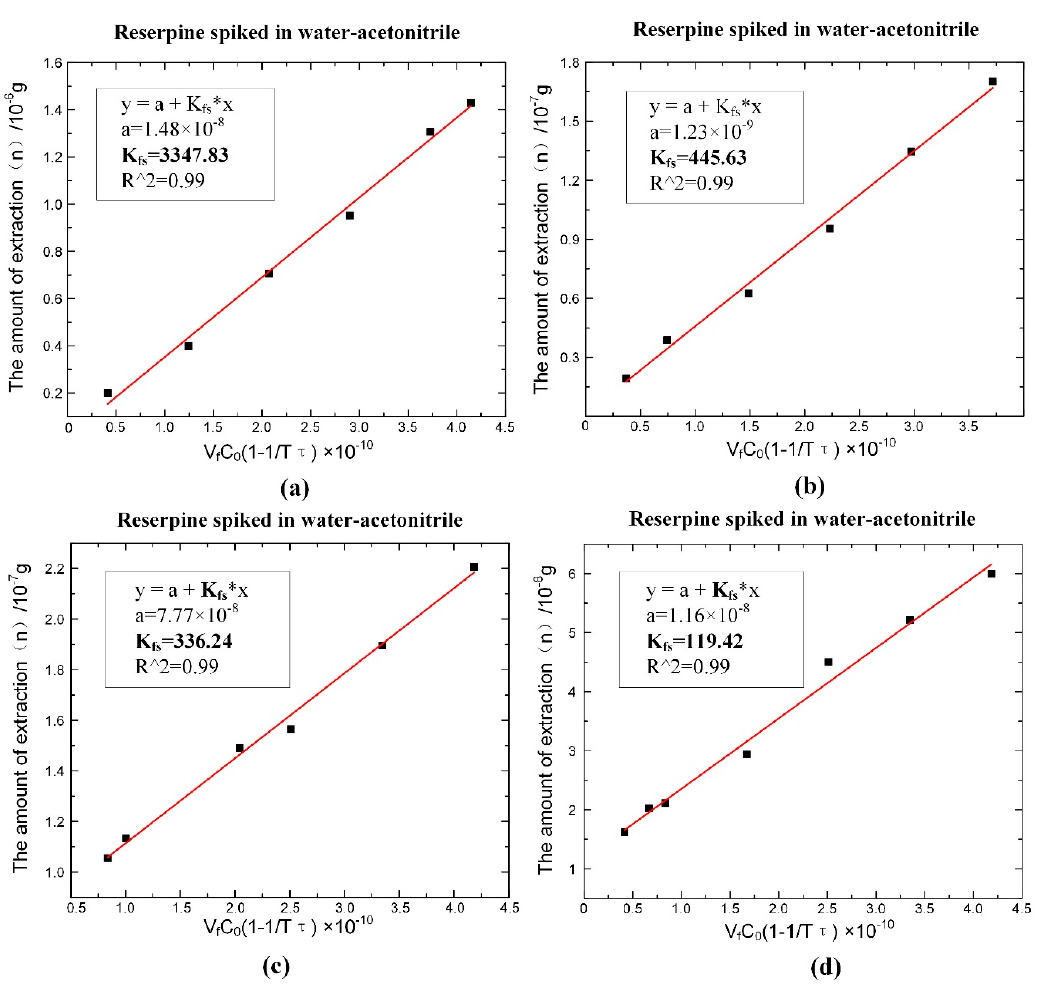
Figure 8. The fitting result of the distribution coe ffi cient k fs of the single compound under the optimal extraction conditions. ( a ) k fs of reserpine spiked in water-acetonitrile. ( b ) k fs of clenbuterol spiked in water-acetonitrile. ( c ) k fs of reserpine spiked in urine. ( d ) k fs of reserpine spiked in